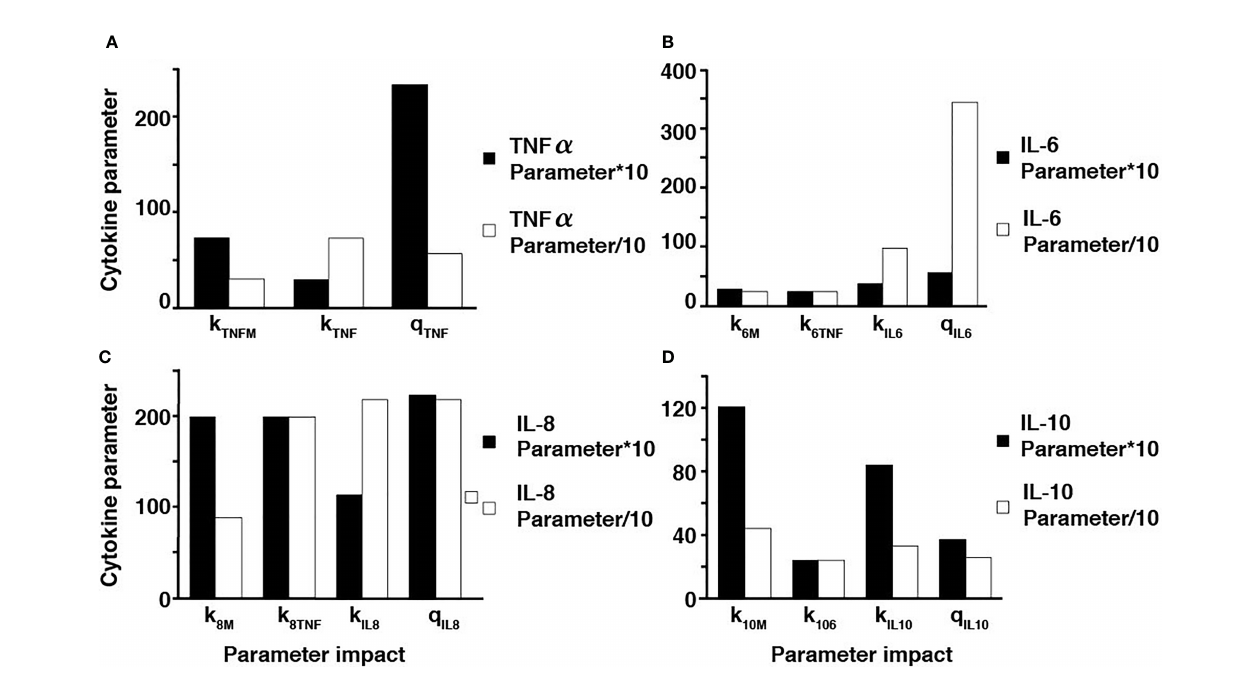
FIGURE 6 | Parameter adjustments of the individual cytokines. A ten-fold increase and decrease in the TNF- ⍺ parameters (A) , IL-6 parameters (B) , IL-8 parameters (C) , and IL-10 parameters (D) .